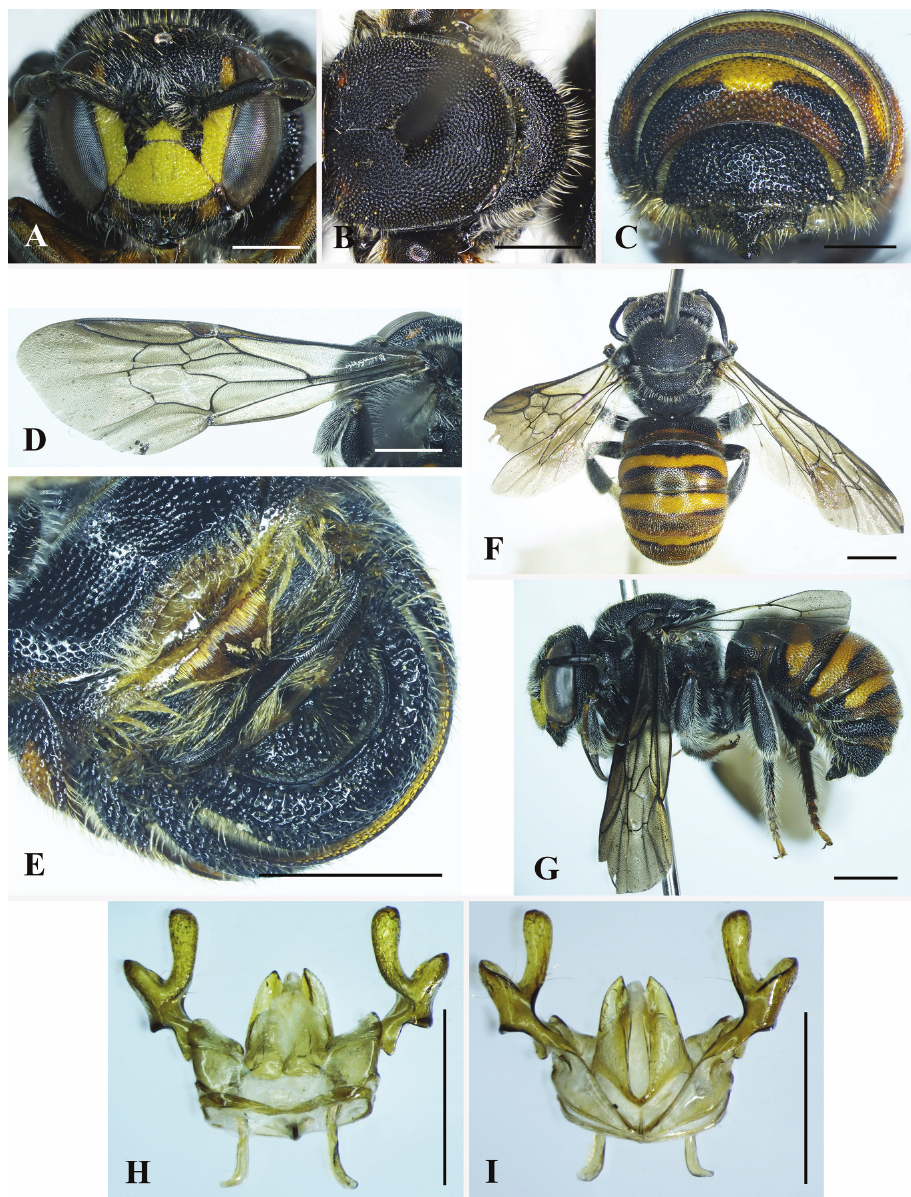
Figure 3. A–I Bathanthidium ( Bathanthidium s. str.) paco Tran & Nguyen, sp. nov., paratype, male A head in frontal view B mesoscutum and scutellum in dorsal view C T4–7 in dorsal view D fore wing in dorsal view E abdomen in latero-ventral view F habitus in dorsal view G habitus in lateral view H genitalia in dorsal view I genitalia in ventral view. Scale bars: 1mm ( A, B, D, E, F, G ); 0.5 mm ( C, H, I